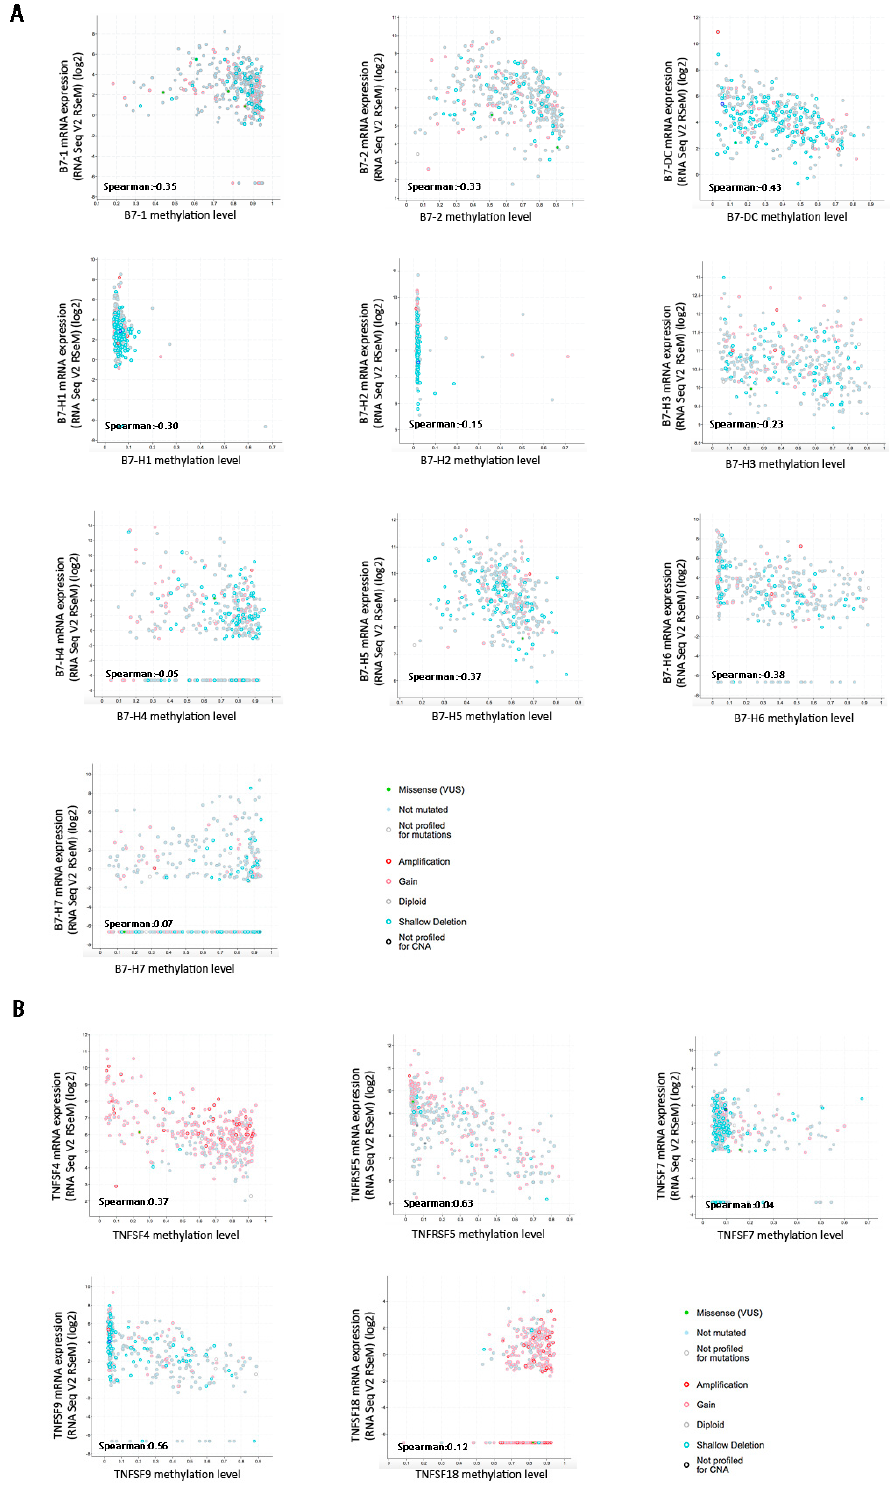
Figure 3. Spearman correlation between the promoter DNA methylation and mRNA expression of the B7 and TNFR families in HCC. ( A ) The mRNA levels of B7 family are negative correlated with their promoter methylated respectively in 371 HCC samples. ( B ) The mRNA levels of TNFR family are negative correlated with their promoter methylated respectively in 371 HCC